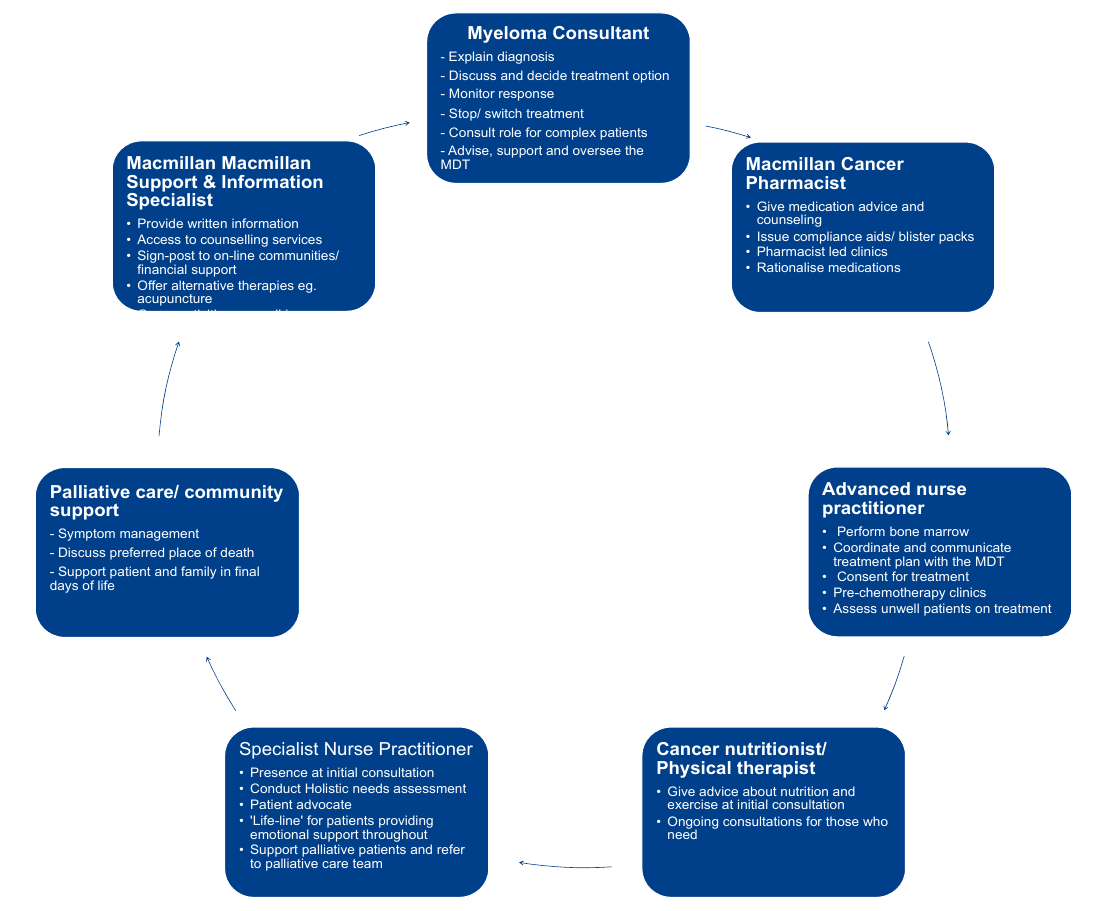
Figure 2. Reprinted with permission from A holistic myeloma clinic model of care, adapted from Sharpley FA et al. (2021) [19].